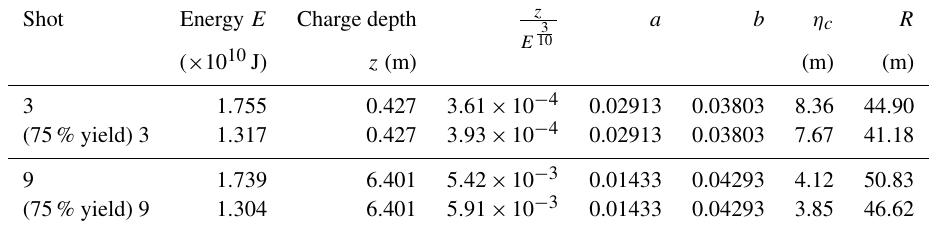
Table 2. Numerical values used in Mono Lake